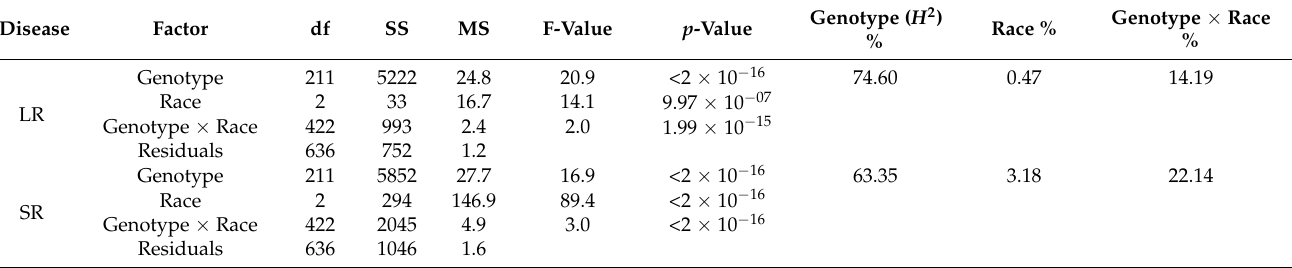
Figure 2. Pairwise correlation analysis of leaf rust (LR) and stem rust (SR) infection type. Two-way ANOVA revealed a strong significant effect ( p < 0.001) of two factors (genotype and race), both separately and combined, on the resistance to LR and SR (Table 1). The broad-sense heritability ( H 2 ) of resistance to LR was higher than for resistance to SR (Table 1). Table 1. ANOVA analyses of infection type of LR and SR.